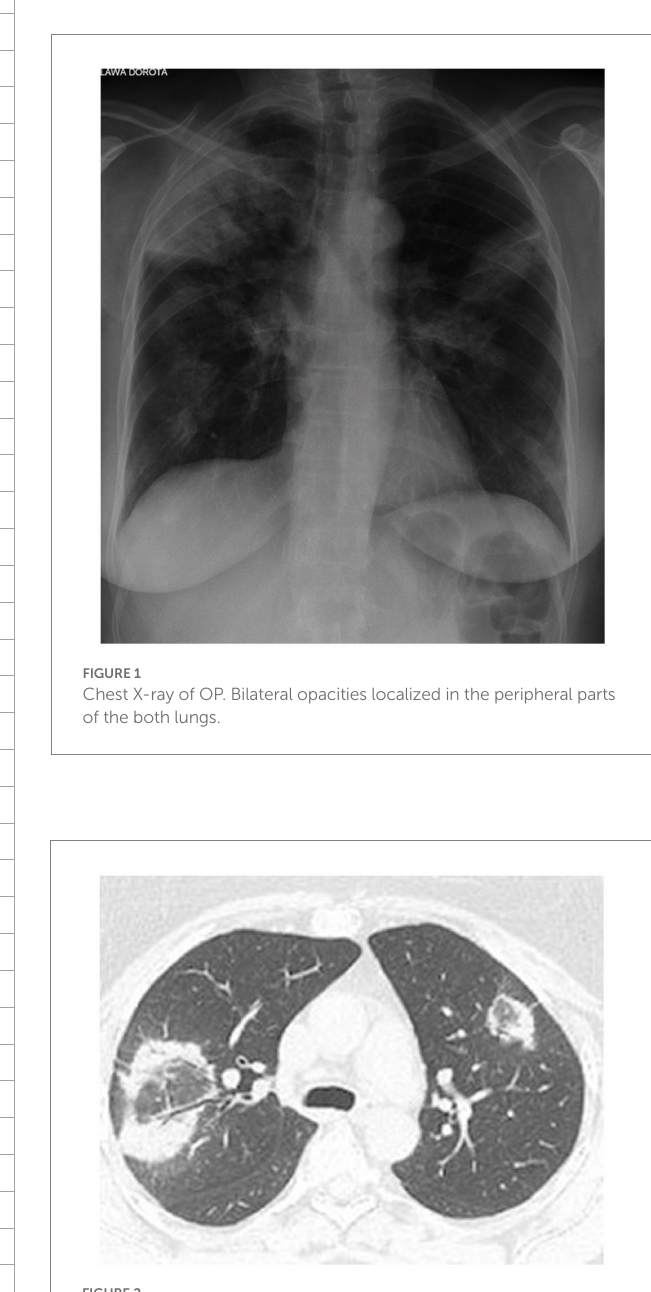
FIGURE 2 High resolution computed tomography scan of a patient with COP. Bilateral ground glass opacities with associated peripheral consolidations forming an atoll